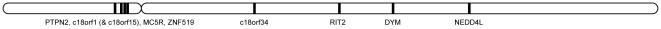
Location of interesting genes on chromosome 18.The location of the genes that showed some evidence of replication are highlighted along chromosome 18.